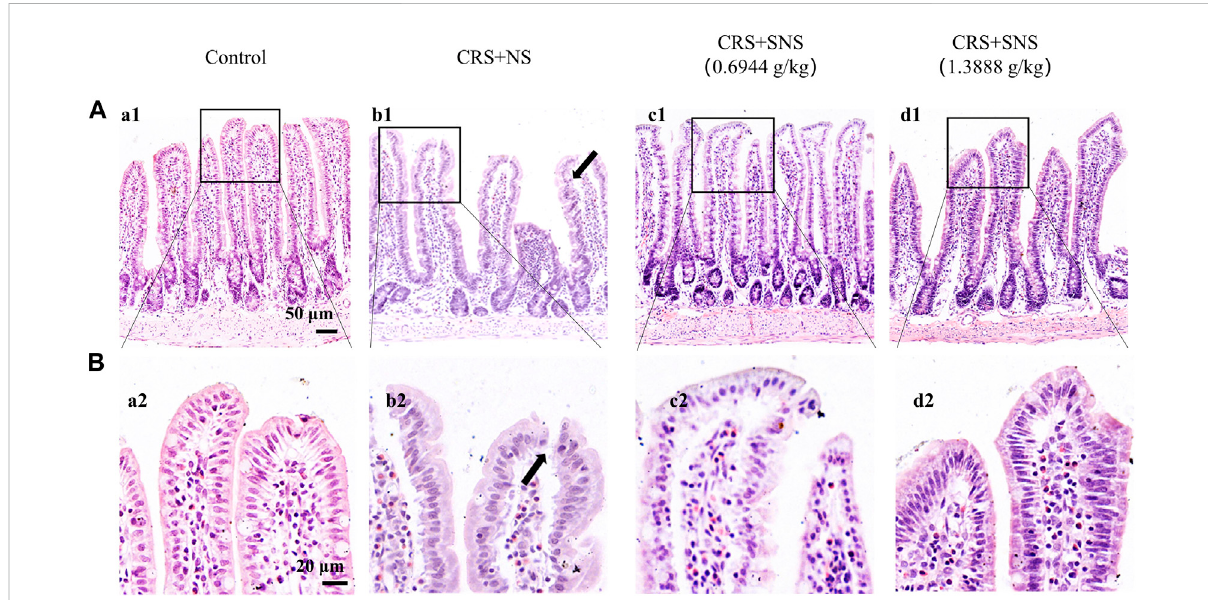
FIGURE 6 Effect of the SNS treatment on morphological changes of the ileum. (A) Representative low magni fi cation of HE staining images of the ileum in the Control (a1), CRS + NS (b1), CRS + SNS(0.6944 g/kg) (c1), and CRS + SNS (1.3888 g/kg) (d1) groups, respectively. Bar = 50 μ m. (B) Representative high magni fi cation of HE-staining images of the ileum in the Control (a2), CRS + NS (b2), CRS + SNS(0.6944 g/kg) (c2), CRS + SNS (1.3888 g/kg) (d2) groups, respectively. Bar = 20 μ m. (A,B) n =